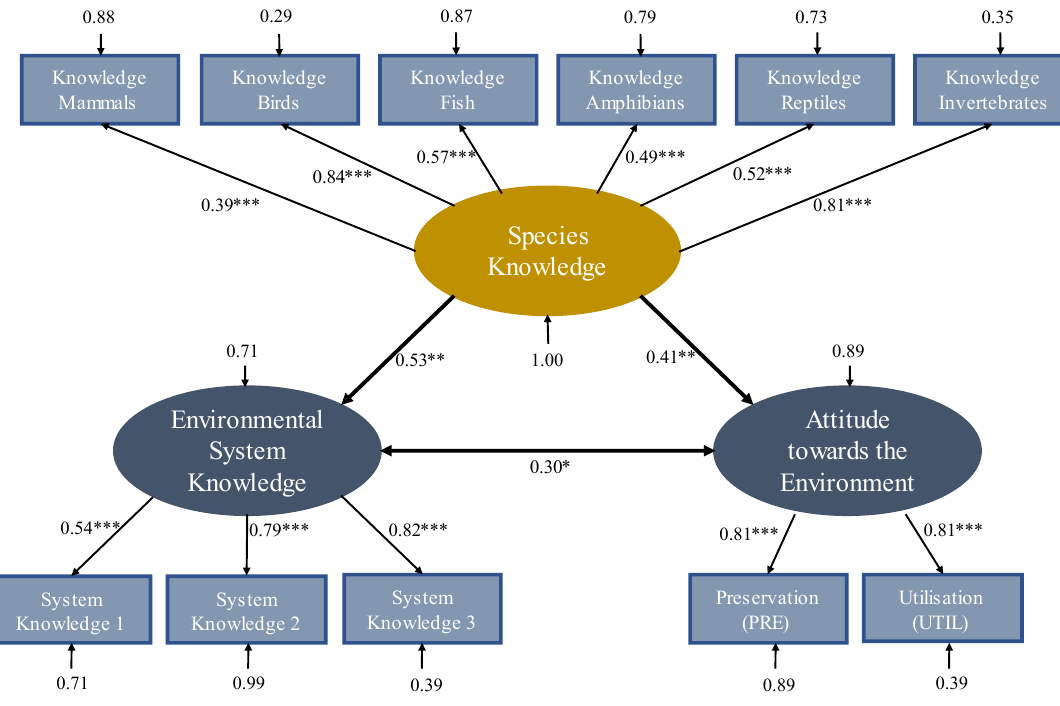
Figure 3. The influence of species knowledge on environmental system knowledge and attitude towards the environment among students. Notes: squared boxes represent manifest variables; oval boxes represent latent variables. Numerical values indicate the standardized multiple regression coefficients (β -values) or Pearson correlation coefficients (see double arrow). These coefficients describe the strength of the influence. Arrows without an origin denote the measurement error proportion or the unexplained variance proportion. *** p < 0.001; ** p < 0.01; * p < 0.05; N = 103.